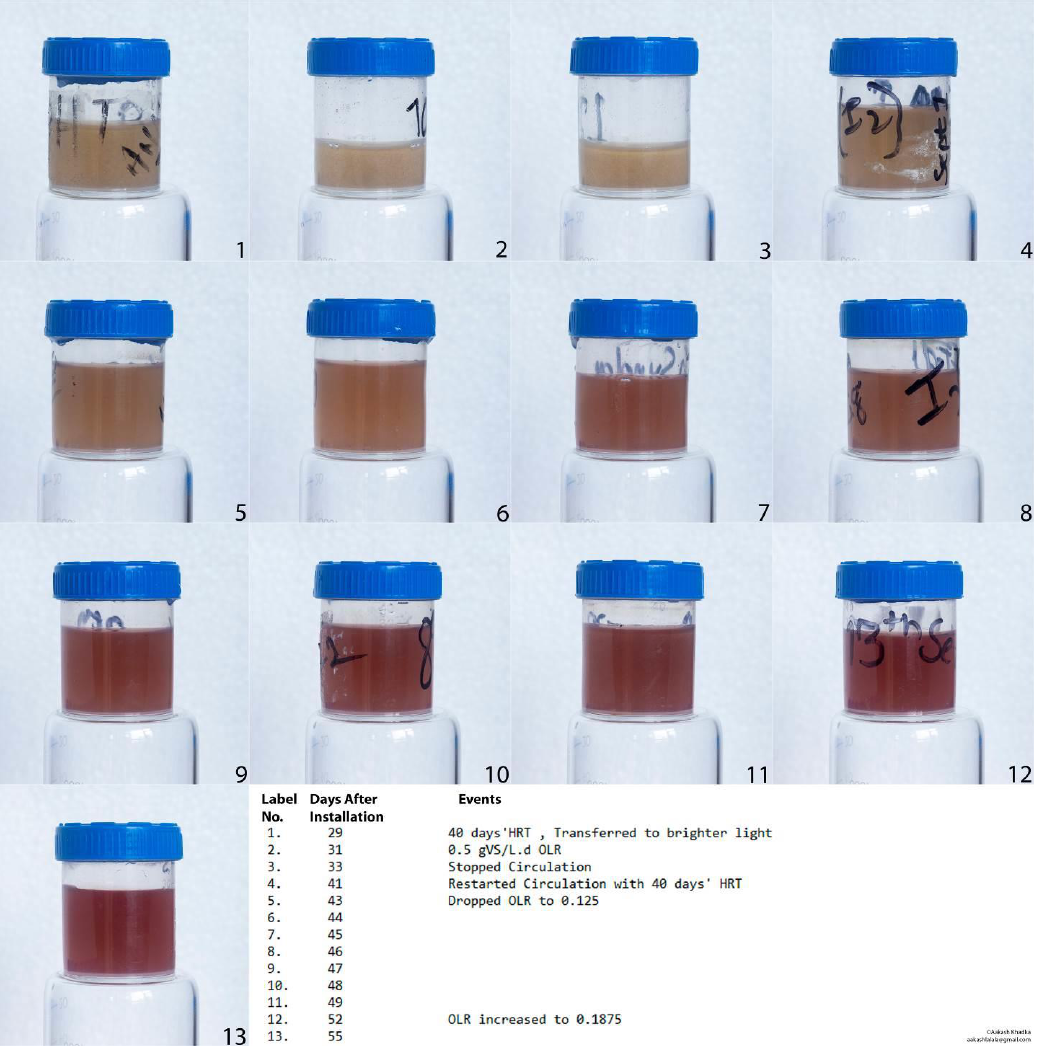
Figure 5. Record of color change in effluent from the second reactor indicating invasion of a photo fermentative microbial community.